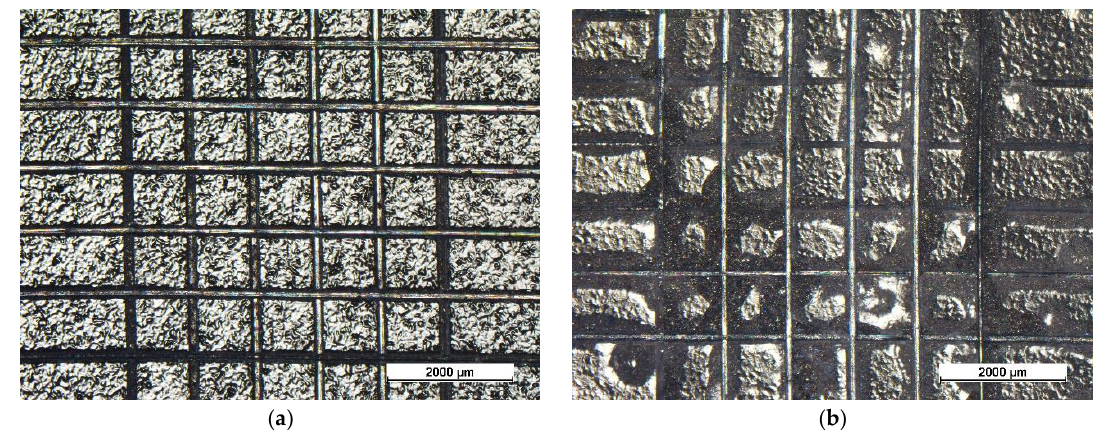
Figure 9. Cross Cut Test results of sample C before ( a ) and after ( b ) exposure in salt spray chamber, observed with stereomicroscope.